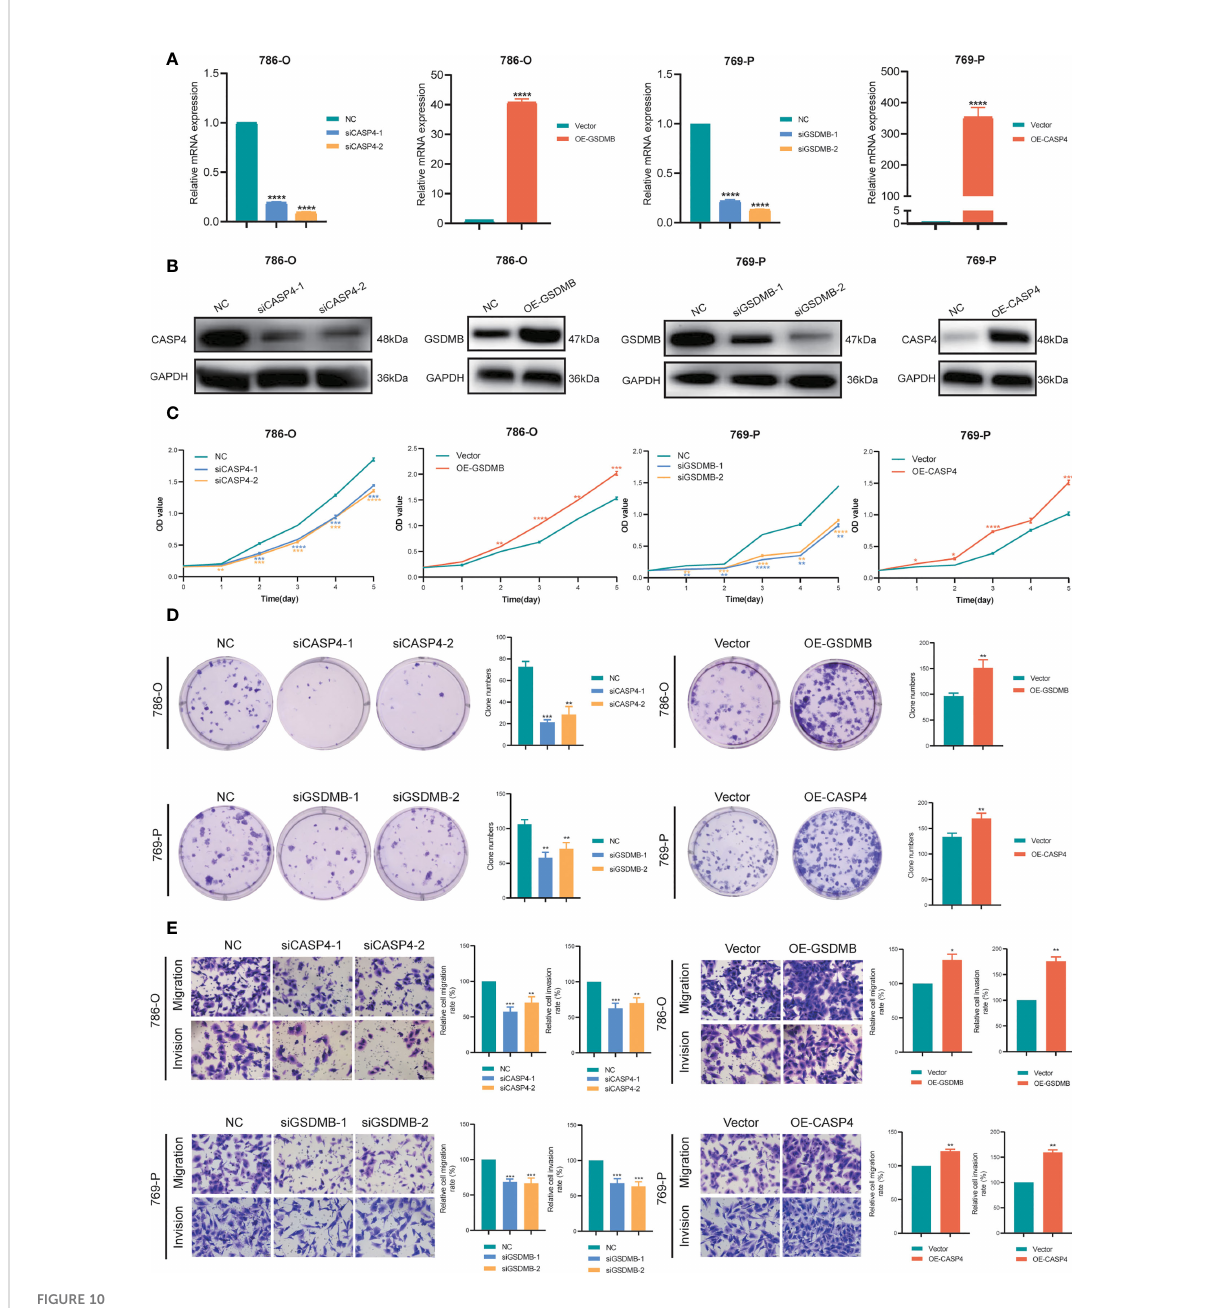
FIGURE 10 Veri fi cation of CASP4 and GSDMB for proliferation, migration, and invasion in ccRCC. (A, B) Construction and veri fi cation of two siRNA speci fi cally targeting at CASP4 (siCASP4-1, si-CASP4-2) and GSDMB (siGSDMB-1, siGSDMB-2) respectively, and overexpressing vector (OE-CASP4 and OE-GSDMB). (C, D) CCK-8 assays, and colony formation assays to detect ccRCC cell proliferation. (E) Transwell migration/invasion assay to analyse the ability of ccRCC cell migration and invasion. *P < 0.05; ** P < 0.01; *** P< 0.001; **** P<